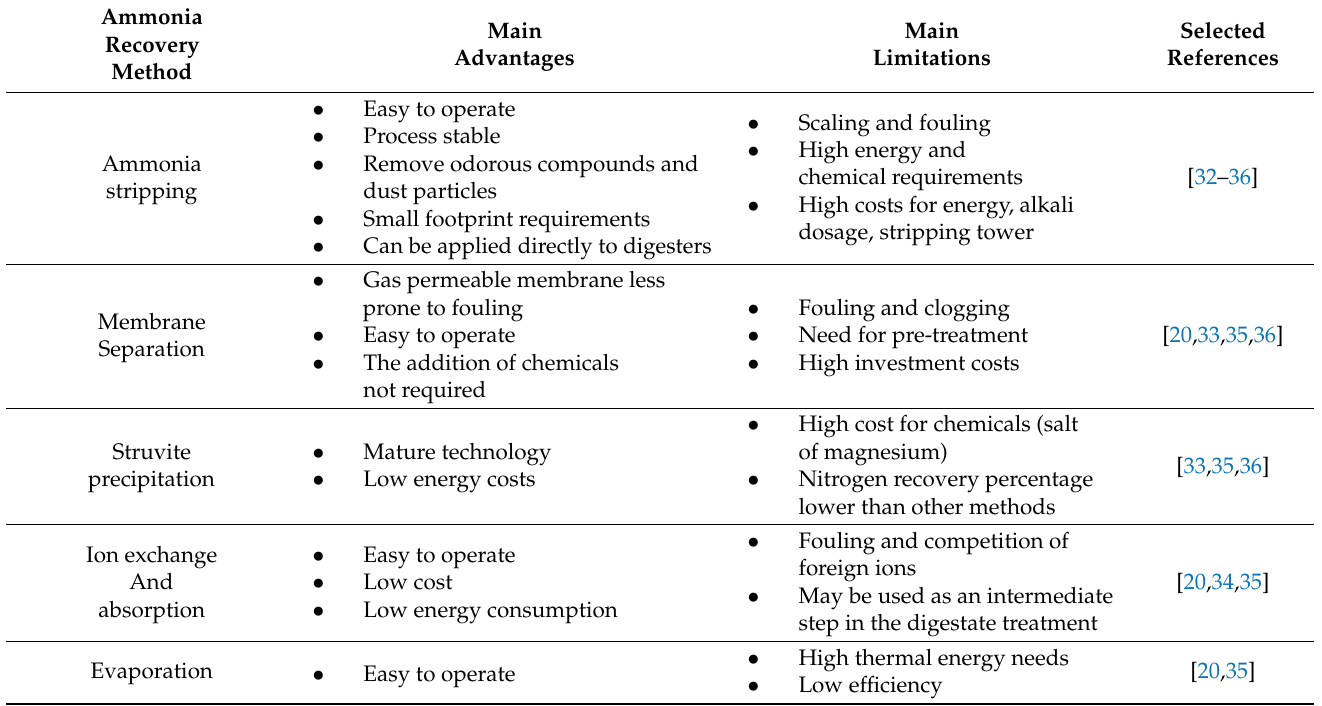
Table 1. Main advantages and limitations of ammonia-recovery